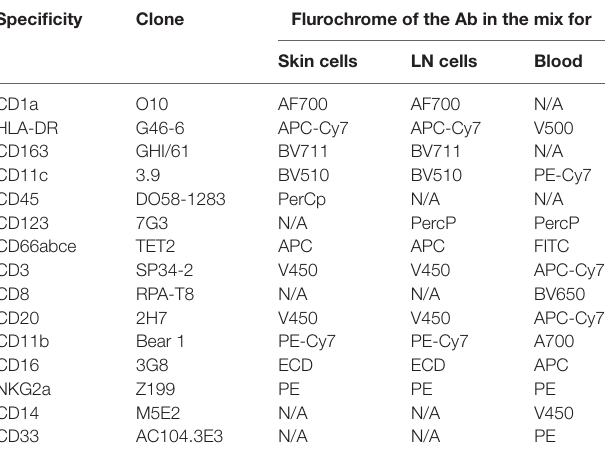
TaBle 1 | Panels of antibodies used for flow cytometry staining.